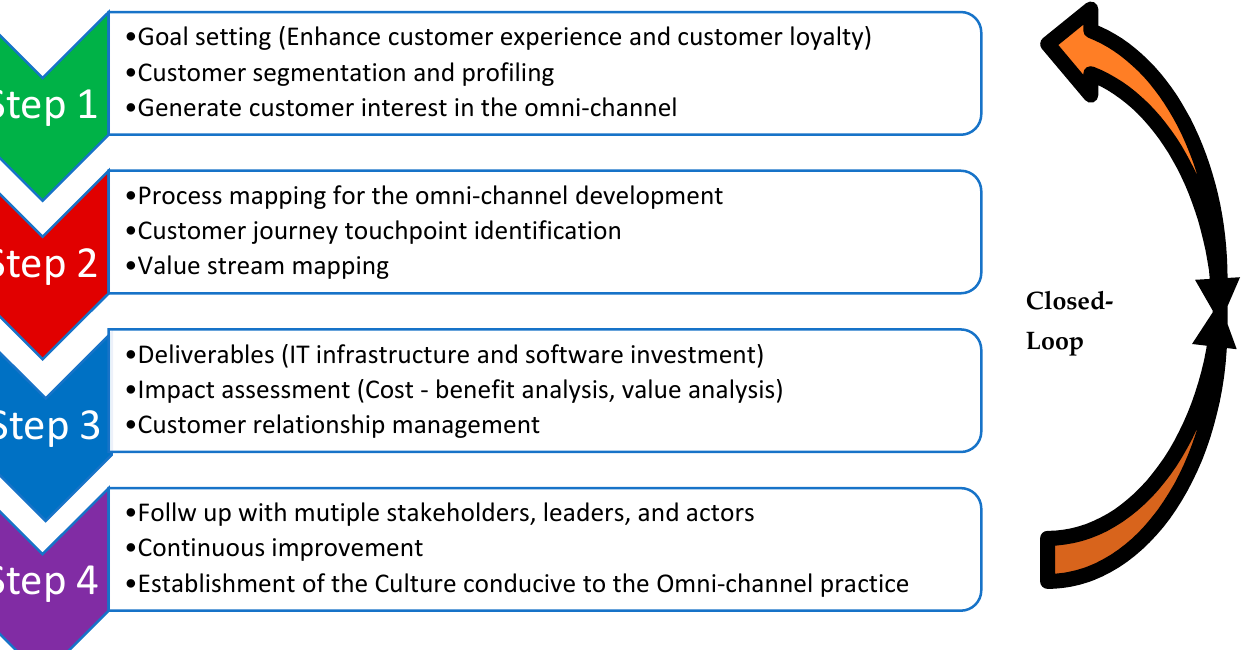
Figure 4. Action Items for Building the Omni-Channel.